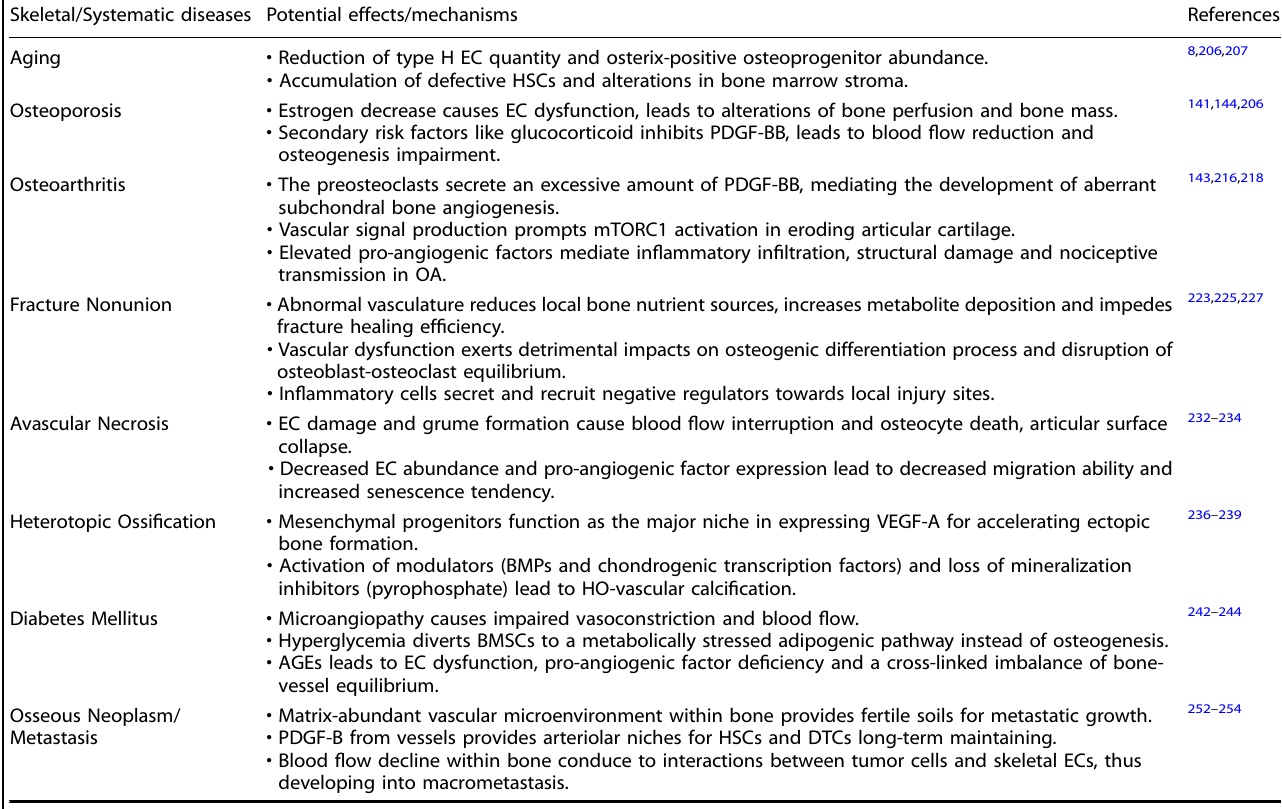
Table 4. Summary of skeletal and systematic diseases associated with vasculature pathological alterations Skeletal/Systematic diseases Potential effects/mechanisms Aging